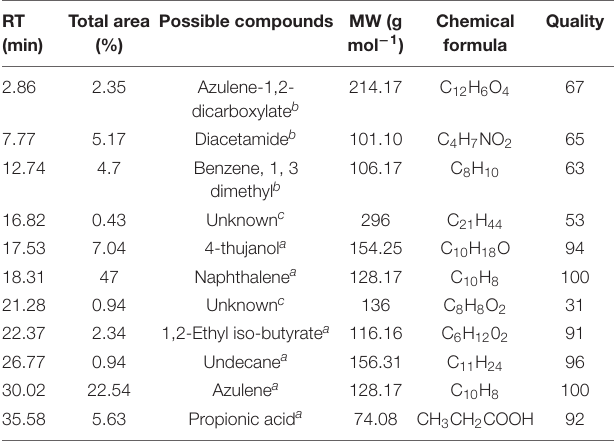
TABLE 7 | GC/MS- SPME analysis of the volatile organic compounds (VOCs) emitted by an 8-day-old endophytic Curvularia eragrostidis HelS1 grown on a modified PDA